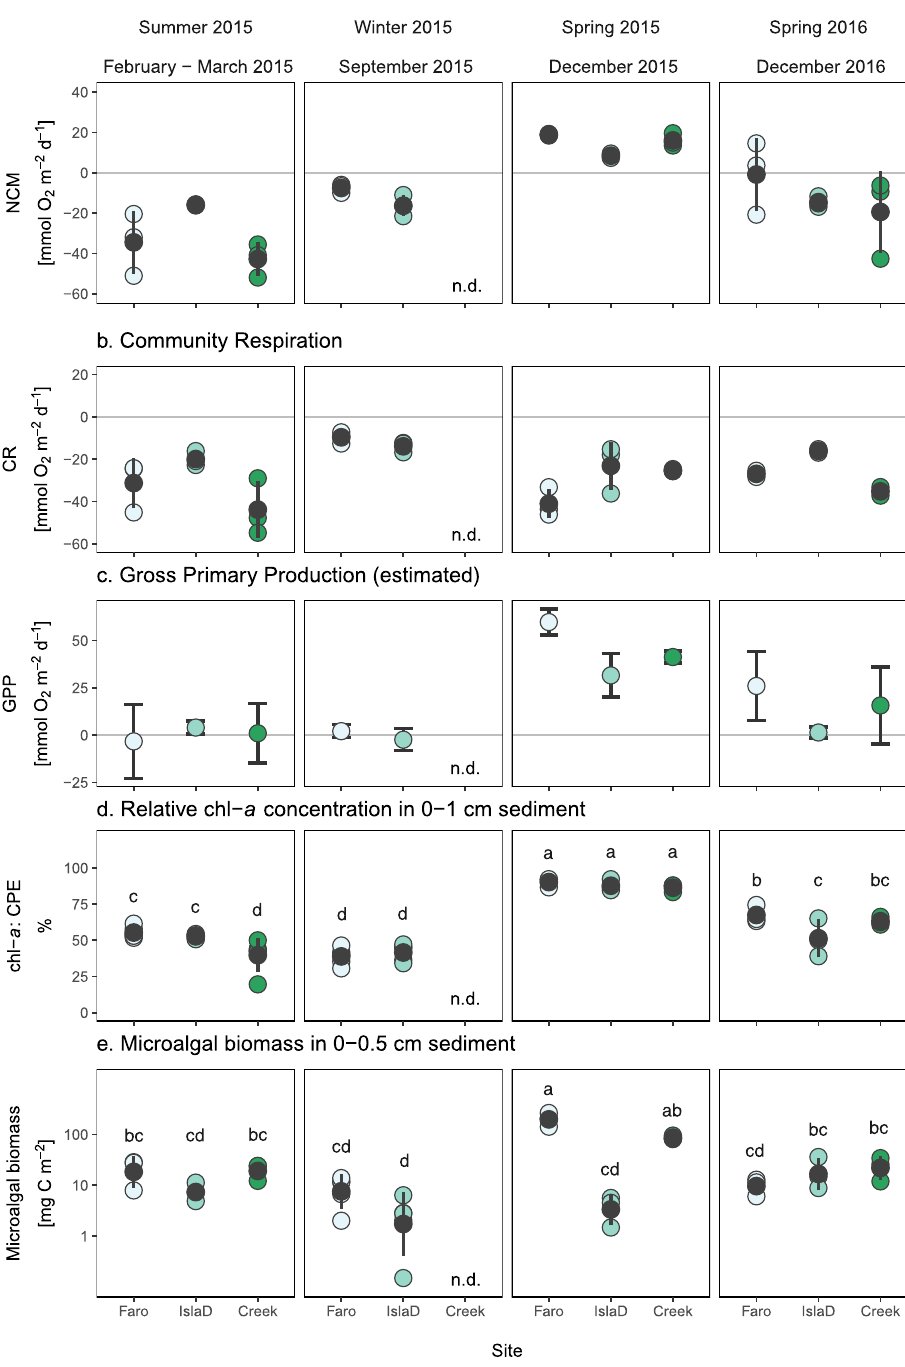
COMMUNICATIONS BIOLOGY| (2021) 4:148